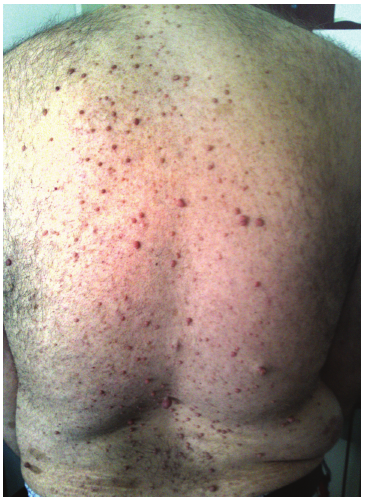
Figure 1: Abundant neurofibromas on dorsal side.